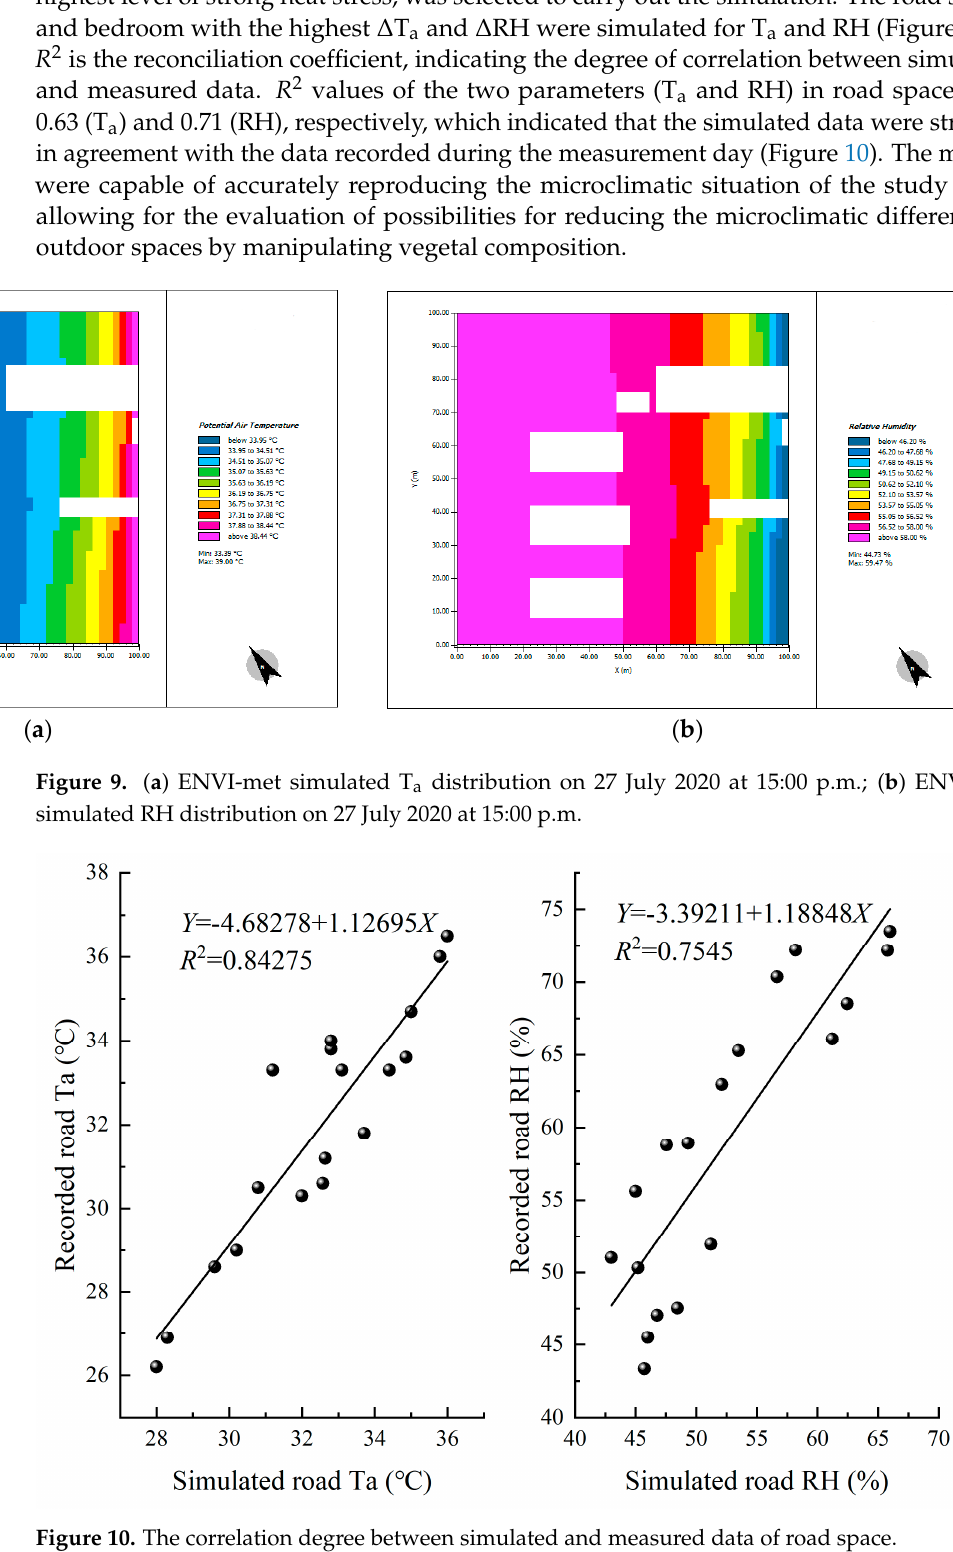
Figure 10. The correlation degree between simulated and measured data of road space.